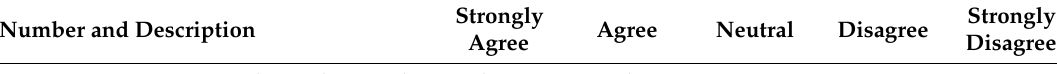
Table A1. The Patient Continuity of Care Questionnaire (PCCQ)